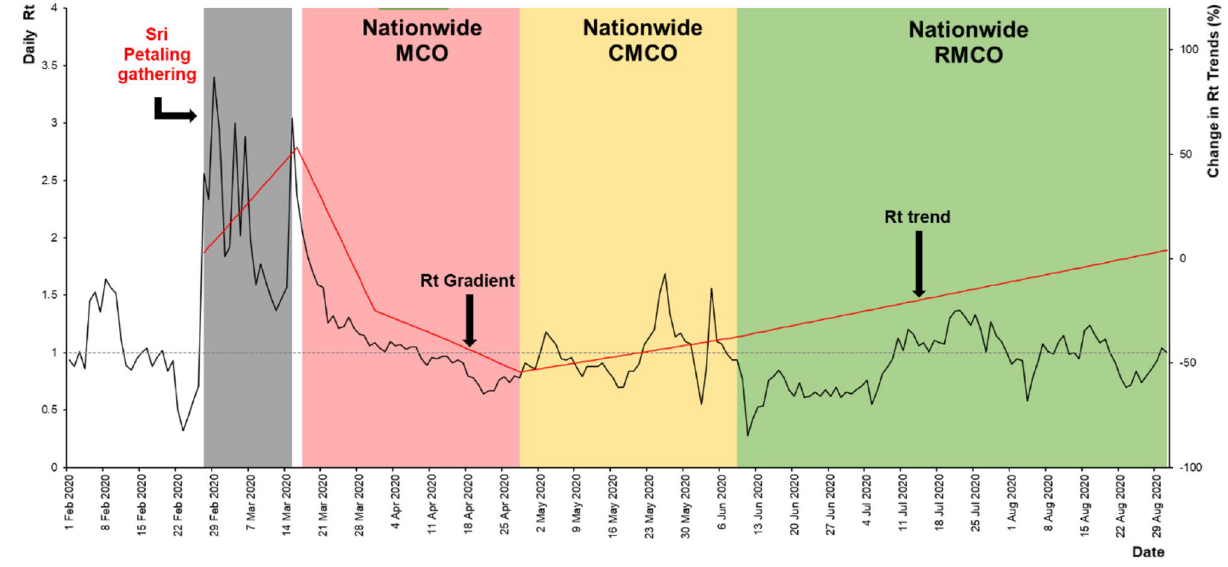
Figure 6. Estimated Rt during the propagation and control events, second wave of COVID-19, 1 February 2020 to 31 August 2020,